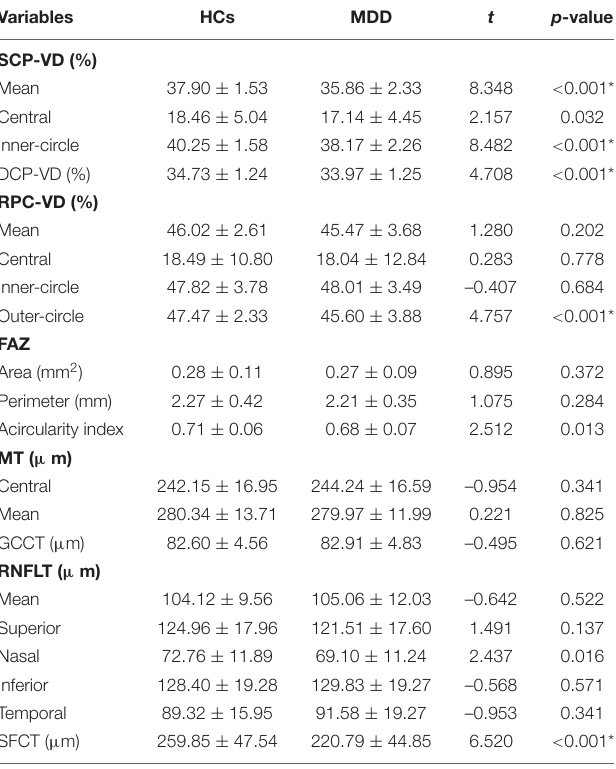
TABLE 2 | Comparison of OCTA and OCT parameters between MDD group and healthy controls.